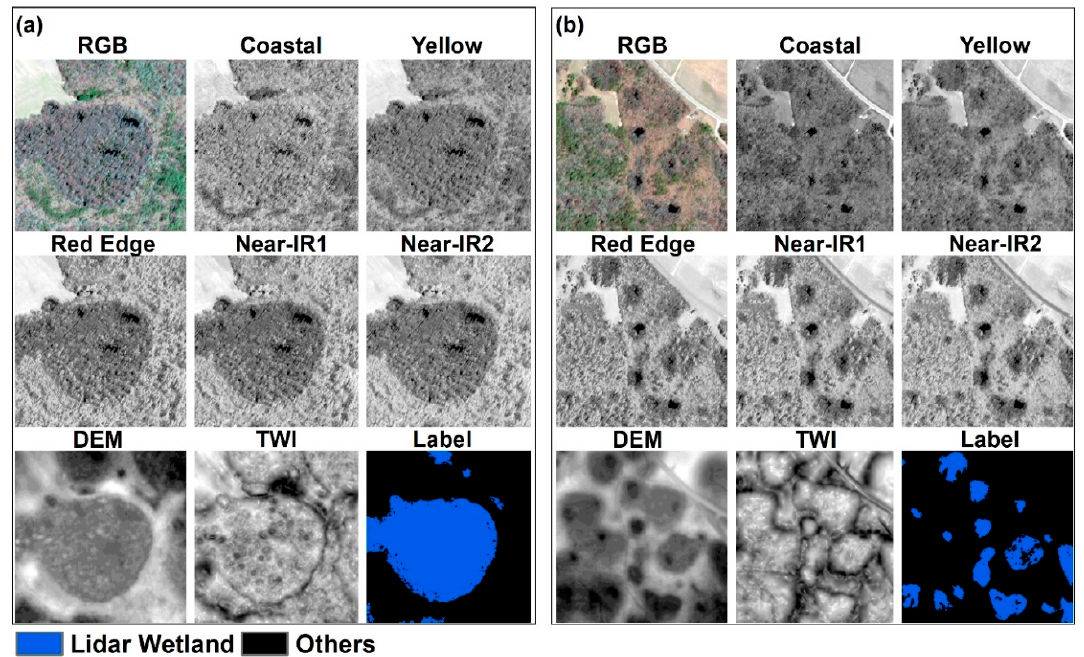
Figure 5. An example of image patches split using an overlapped moving window. We randomly chose two image patches ( a , b ) from the training dataset. RGB: Red, Green, Blue, IR: infrared, DEM: Digital Elevation Model, TWI: Topographic Wetness Index.